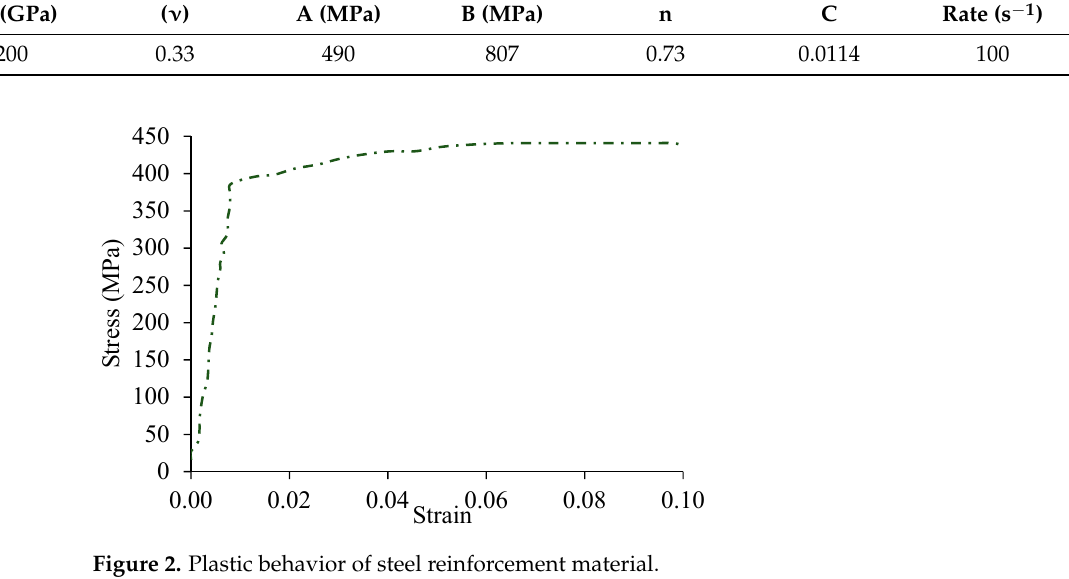
Table 1. Four different sandstone rock surrounding the tunnel opening.